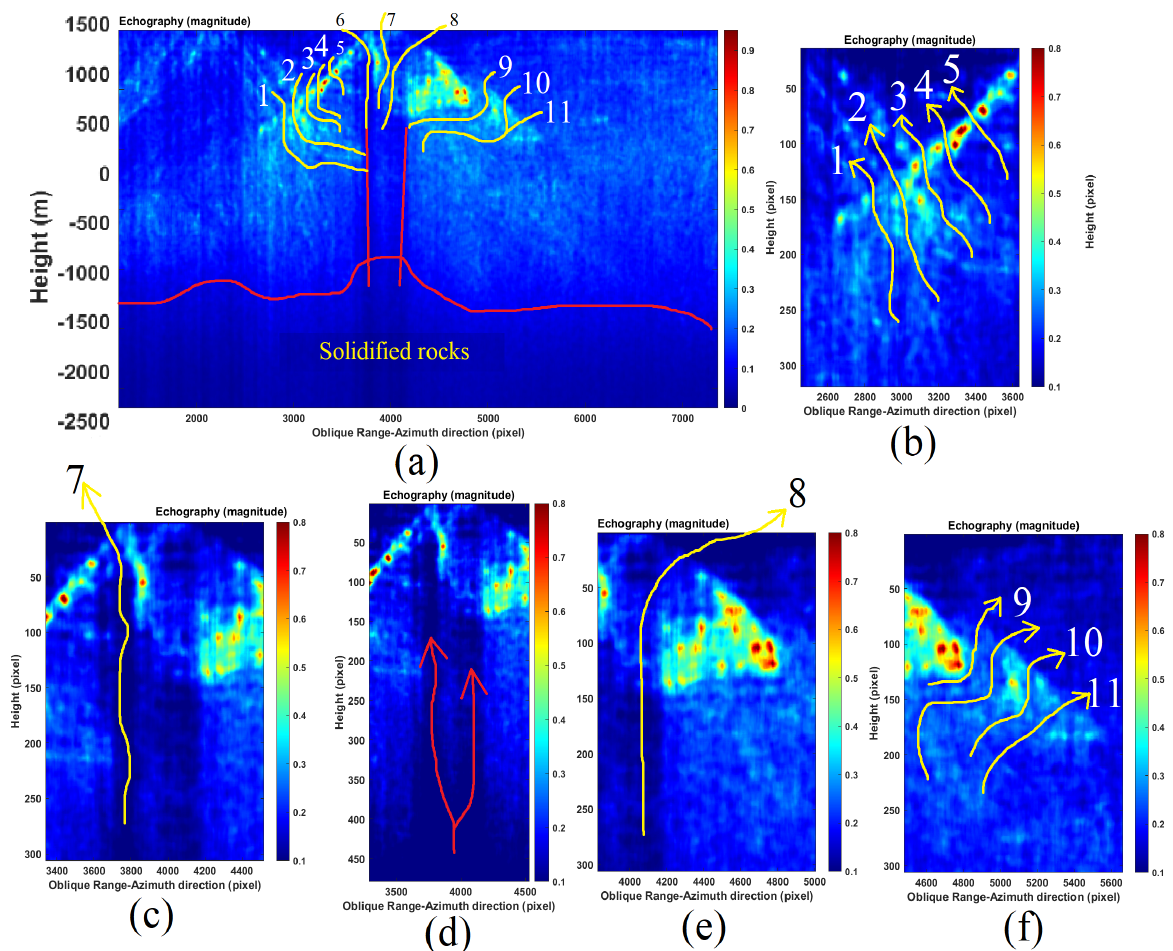
Figure 13. Tomographic results and analysis. ( a ) Tomographic analysis of the external eastern slope of Vesuvius, where potentially 11 magmatic fluid fractures are visible. At the bottom of the tomogram, the presence of a magma chamber is evident. ( b ) Tomographic analysis of the internal eastern slope of Vesuvius, where potentially five magmatic fluid fractures are visible. At the bottom of the tomogram, the presence of a magma chamber is evident. ( c ) Detail of the eastern slope showing an internal feeder conduit. ( d ) Detail of the deepest part of the conduit showing a splitting of the magmatic fluid conduit. ( e ) Detail of the external magmatic fluid conduit (upper part). ( f ) Detail of the eastern slope on the external side (lower